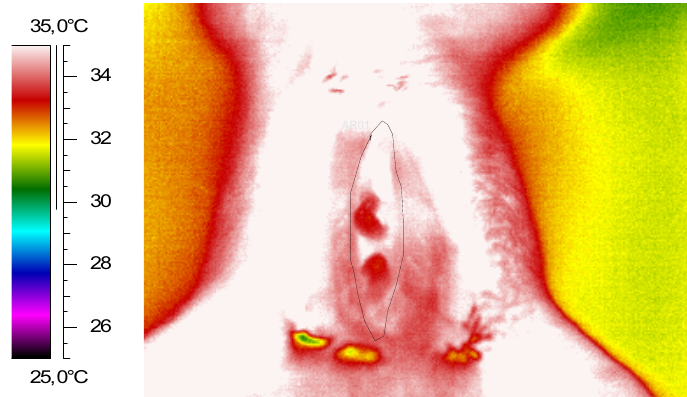
FIGURE 4 – Thermogram in group I (Control)